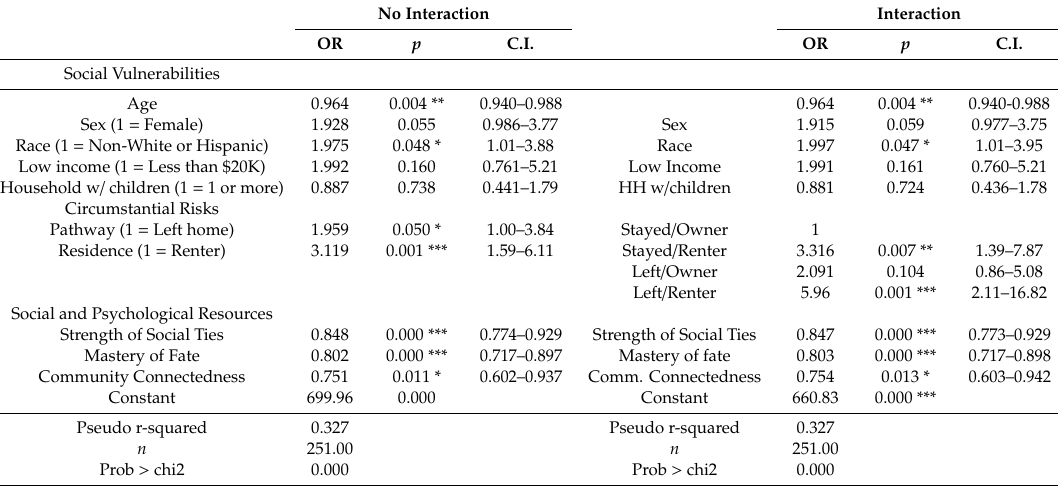
Table 2. Logistic regressions for food insecurity, with and without renter X displacement